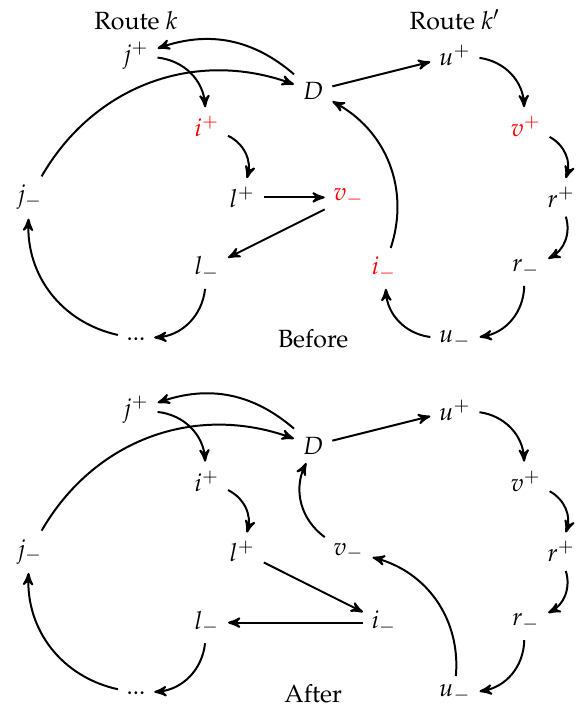
Figure 5. Repair-Destroy Inter-route Swap (RDIS).